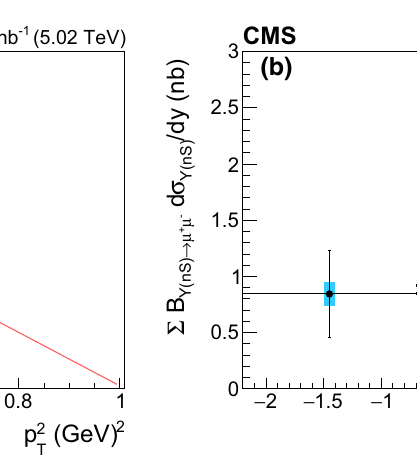
exponential fit of the form e − bp 2 T . In the right plot, the horizontal bars are shown to indicate the width of each y bin. In both plots, the vertical bars represent the statistical uncertainties and the boxes represent the systematic uncertainties